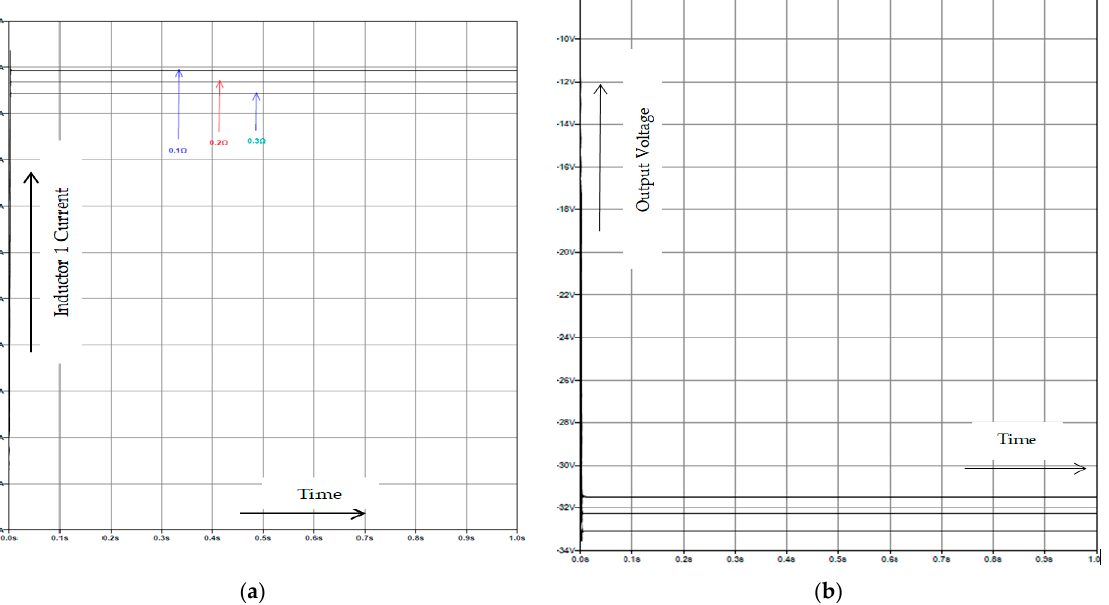
( a ) ( b ) Figure 13. Variation of iL1 and V 0 with change in R L (SEPIC). ( a ) Output Voltage Vs. Control Voltage, ( b ) Inductor 1 Cur- rent Vs. Control Voltage